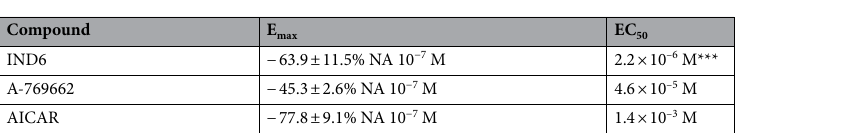
Figure 8. IND6 promotes an AMPK–eNOS-dependent vasodilation of rat thoracic aorta. Concentration– response curves in rat aortic rings with intact endothelium precontracted with noradrenalin 10 −7 M in response to: ( A ) IND6 10 −9 –10 −4 mol/L; ( B ) IND6 10 −9 –10 −4 mol/L in presence of the eNOS inhibitor L-NAME (10 −4 M) or in presence of the AMPK inhibitor SBI-0206965 (10 −4 M): ( C ) AICAR 10 –5 –8 × 10 –3 mol/L, A-769662 and IND6 10 −9 –10 −4 mol/L. The data are represented as means ± SEM; n = 6 rats.